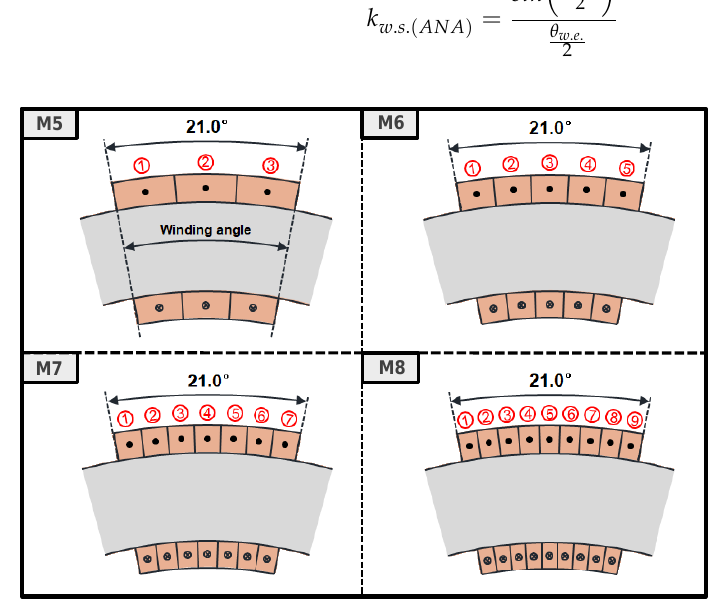
Figure 13. Coil shape according to number of coil turns.